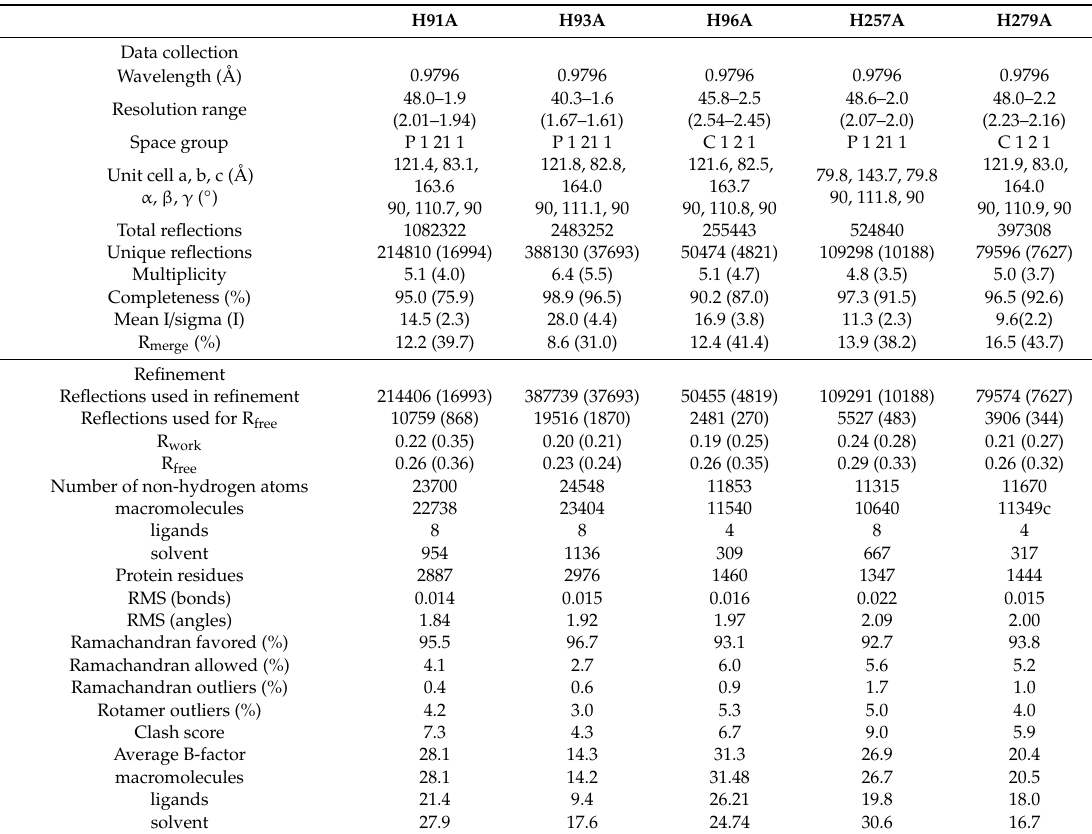
Table 1. Data collection and refinement